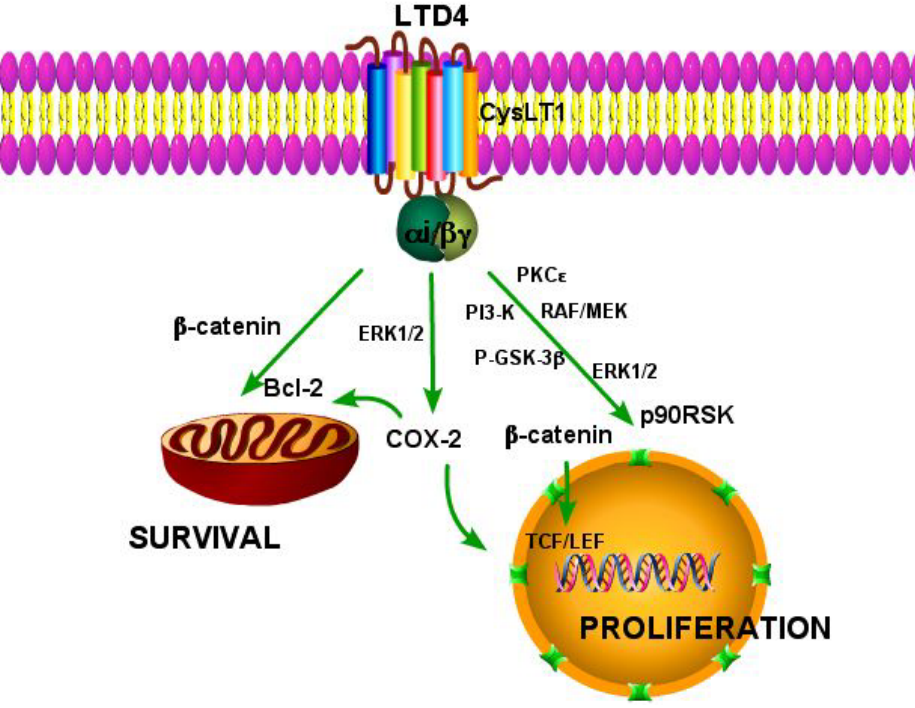
FIGURE 1. A simplified signaling cascade leading to LTD 4 -induced cell survival and cell